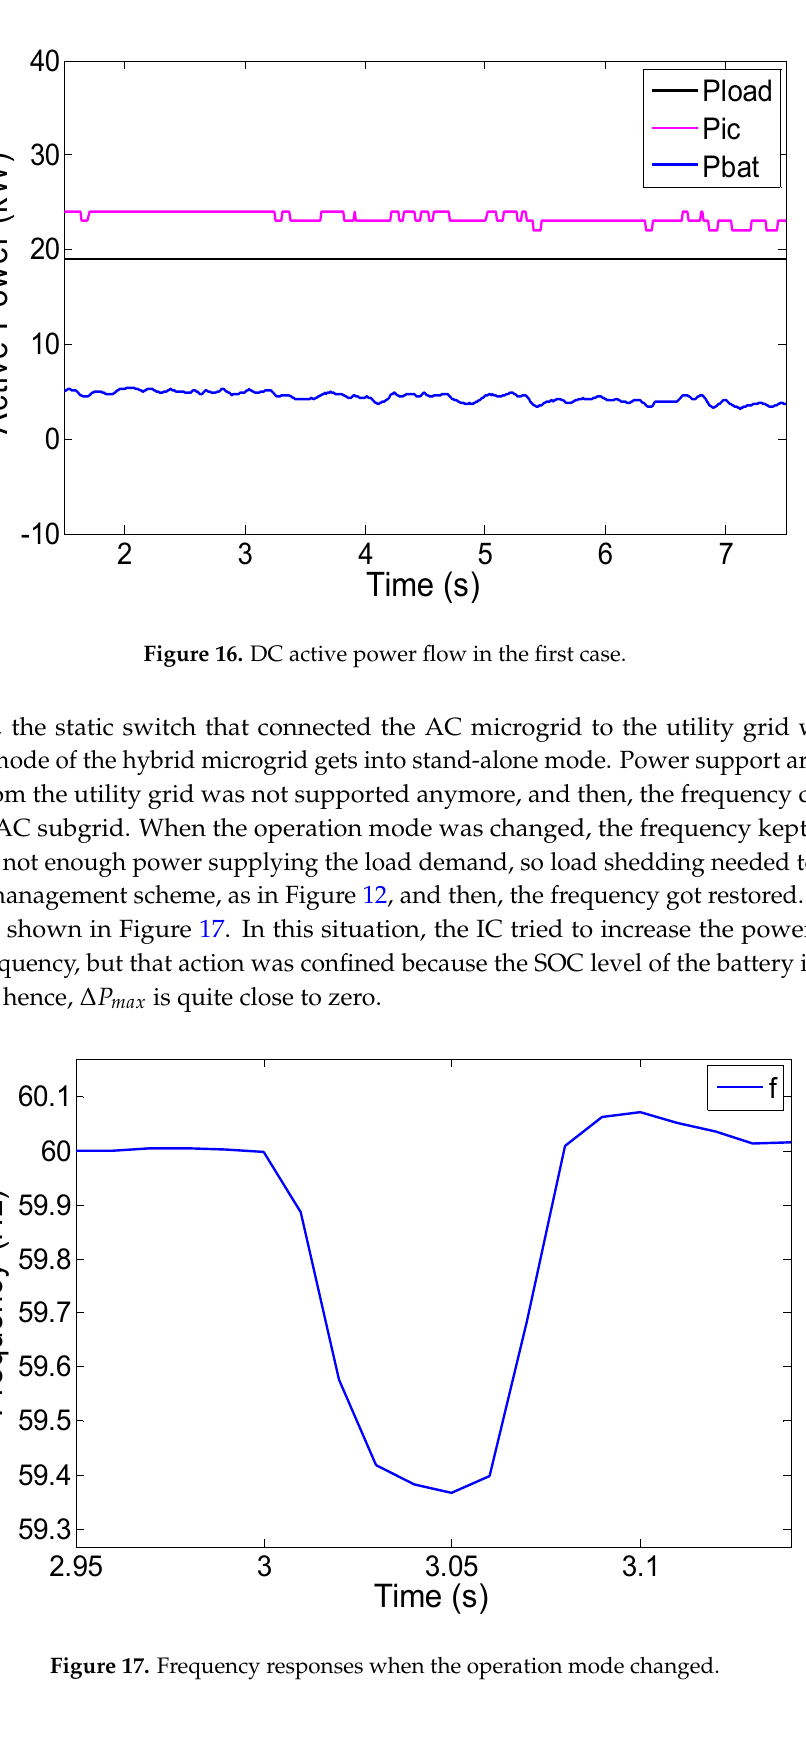
Figure 17. Frequency responses when the operation mode changed.